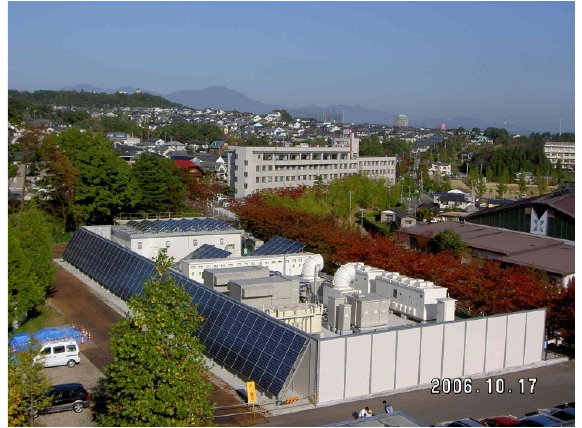
Fig. 3 The Sendai microgrid (Source: NTT